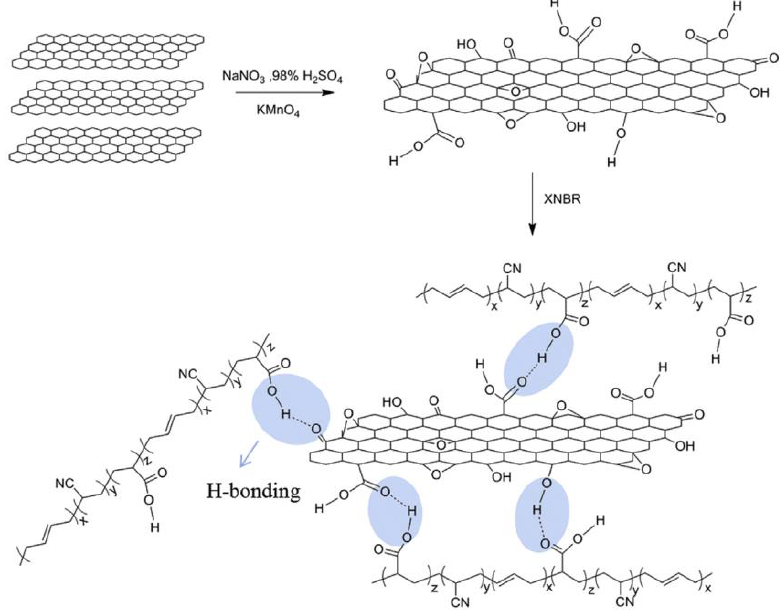
Figure 5. Scheme illustrating preparing procedures and H-bonding interactions between carboxylated acrylonitrile butadiene rubber (XNBR) and GO [94]. (Reproduced from [94] with permission; Copyright 2014 Elsevier).